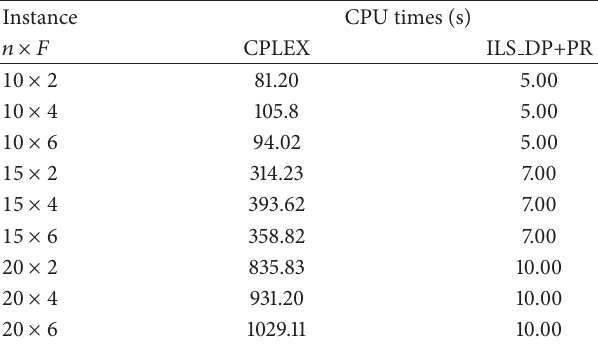
Table 11: Average CPU times (in seconds) of CPLEX and ILS DP+PR.